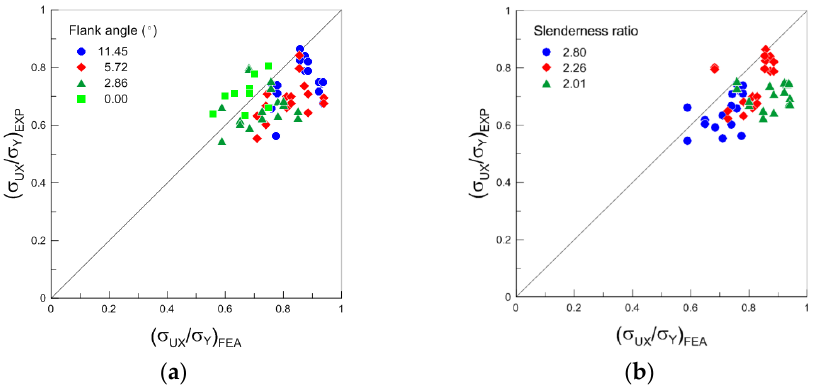
Figure 14. Comparison of FE analysis and experimental results: ( a ) effect of flank angle and ( b ) slenderness ratio. Table 4. Experimental and FE analysis results.